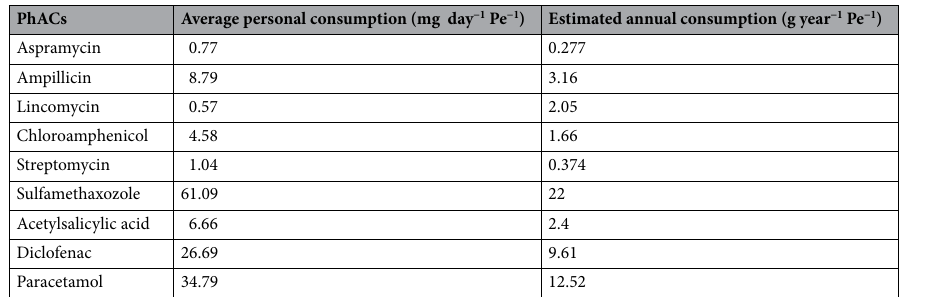
Table 2. Predicated back-estimated consumption of the studied PhACs in the studied region.